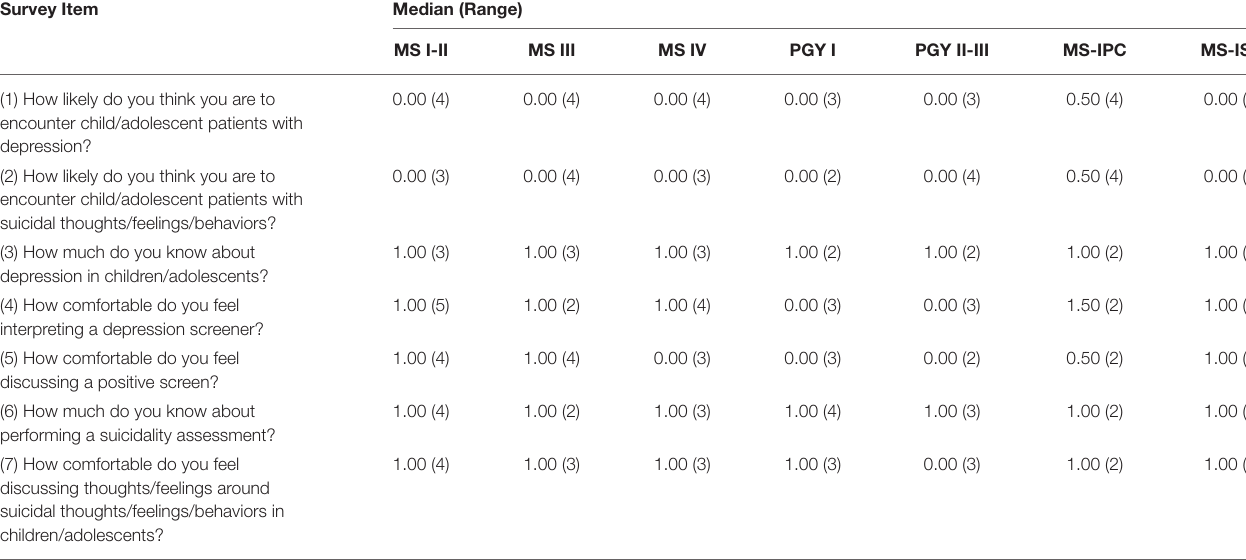
TABLE 3 | Item-level descriptive statistics for difference scores by participant level and intended medical specialty area ( N = 149). Survey